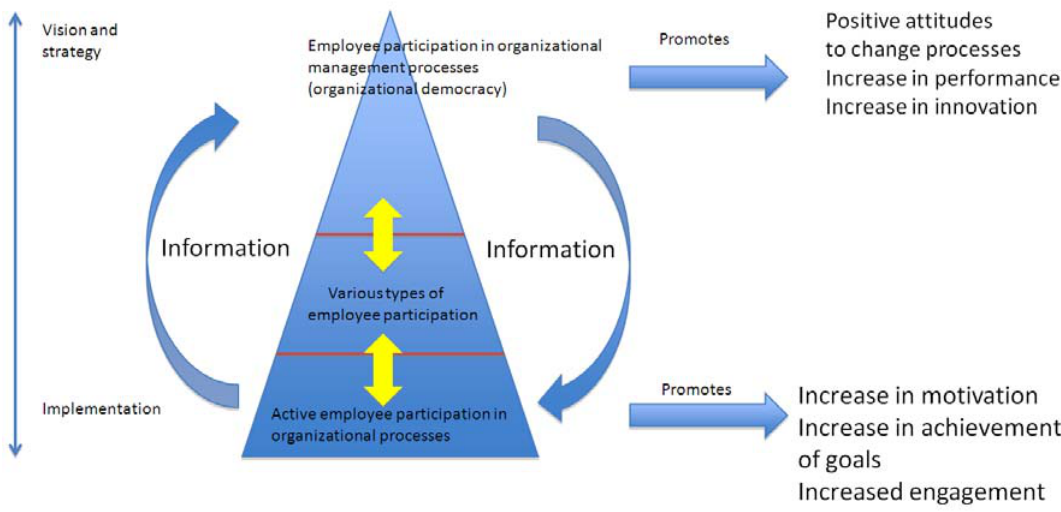
Fig. 4. Organizational employee